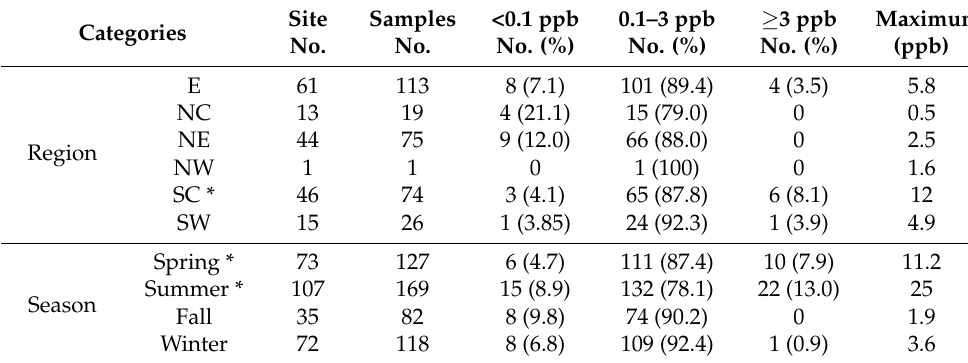
Table 11. Occurrence of Atrazine in Surface Water (Drinking Water MCL = 3